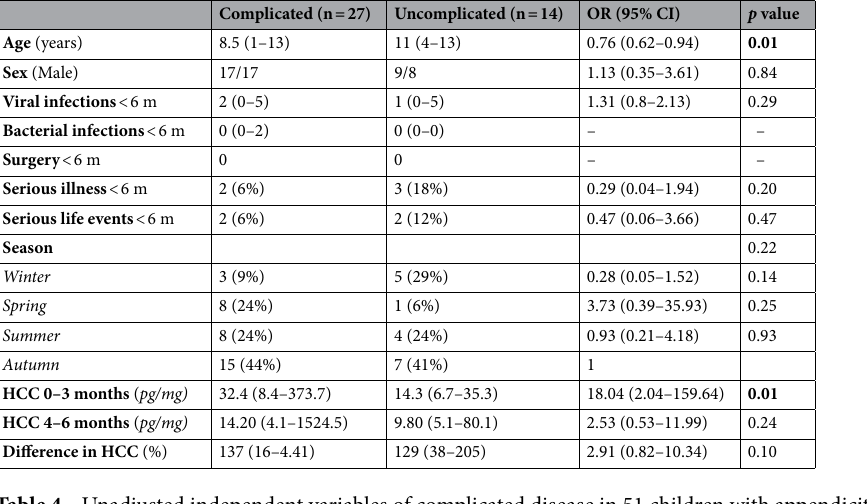
Table 4. Unadjusted independent variables of complicated disease in 51 children with appendicitis. n = 40 for HCC 4–6 months and difference in